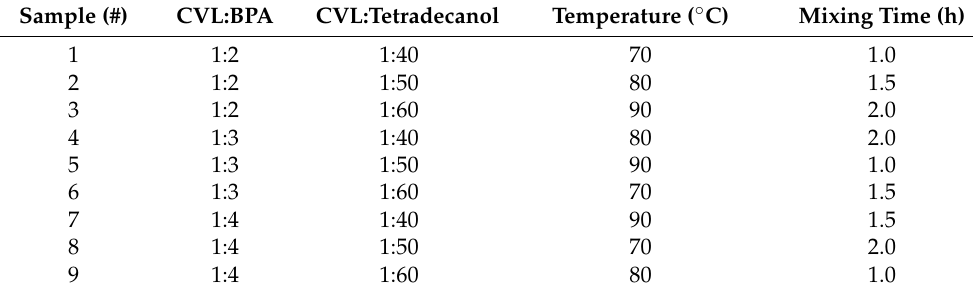
Table 3. Orthogonal experiment